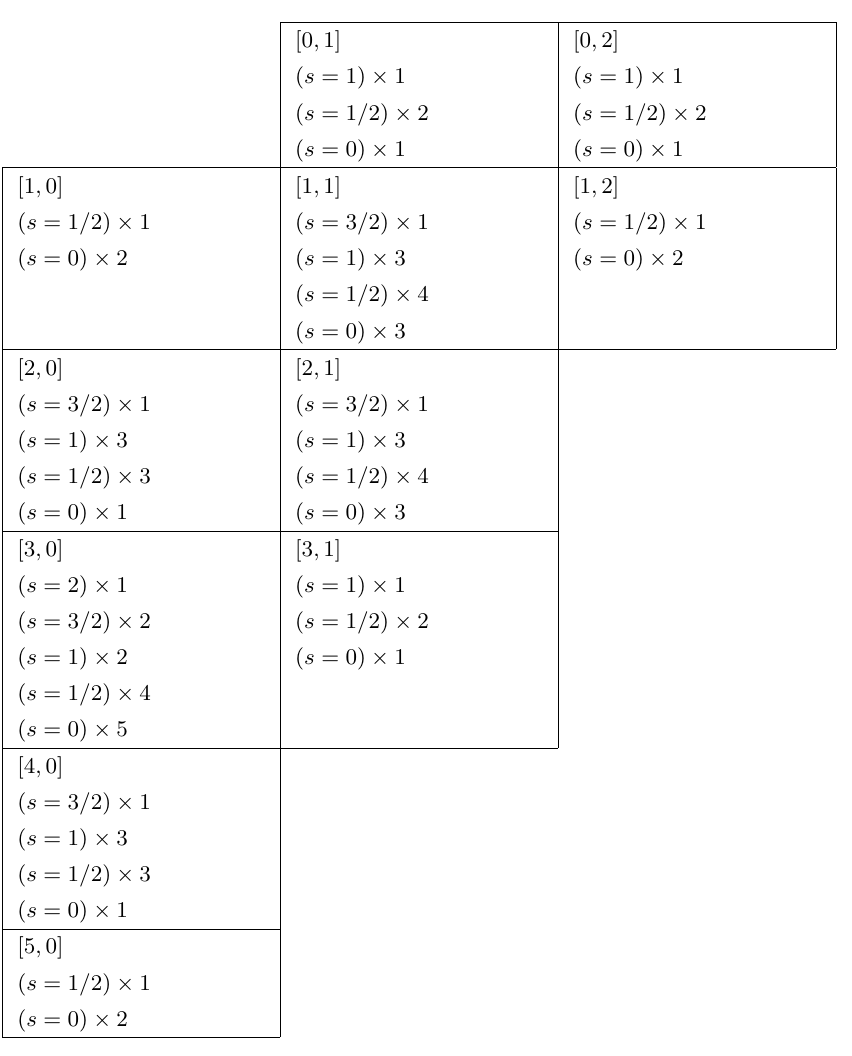
Table 21 . States at KK level n = 3 for the N = 0 G 2 -invariant AdS 4 solution of type